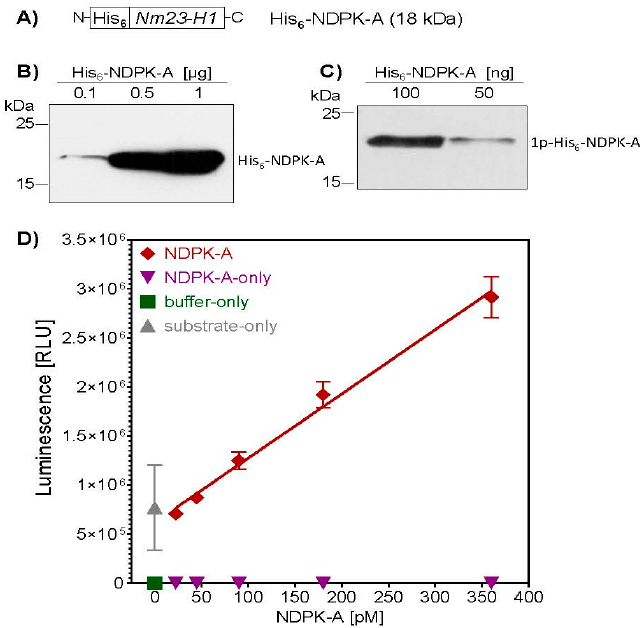
Figure 1. Characterization of recombinant His 6 -NDPK-A. ( A ) After recombinant expression of His 6 -NDPK-A in E. coli and purification via affinity chromatography, protein identity was confirmed by Western blotting with a specific anti-NDPK-A antibody ( B ). The kinase activity of His 6 -NDPK-A was analyzed by measuring the proteins autophosphorylation activity ( C ). His 6 -NDPK-A was incubated with ATP (1 mM) and MgCl 2 (2 mM) for 5 min at room temperature. The reaction was stopped by adding EDTA (5 mM) and the phosphorylated His 6 -NDPK-A intermediate detected by Western blotting with an anti-N1-phosphohistidine (1-pHis) antibody. ( D ) The kinase activity of His 6 -NDPK-A was determined by measuring the substrate conversion status after incubation of increasing amounts His 6 -NDPK-A with substrate for 30 min at room temperature. Controls include His 6 -NDPK-A only, substrate only and bu ff er only. ATP conversion was quantified with the Kinase-Glo ® Luminescent Kinase